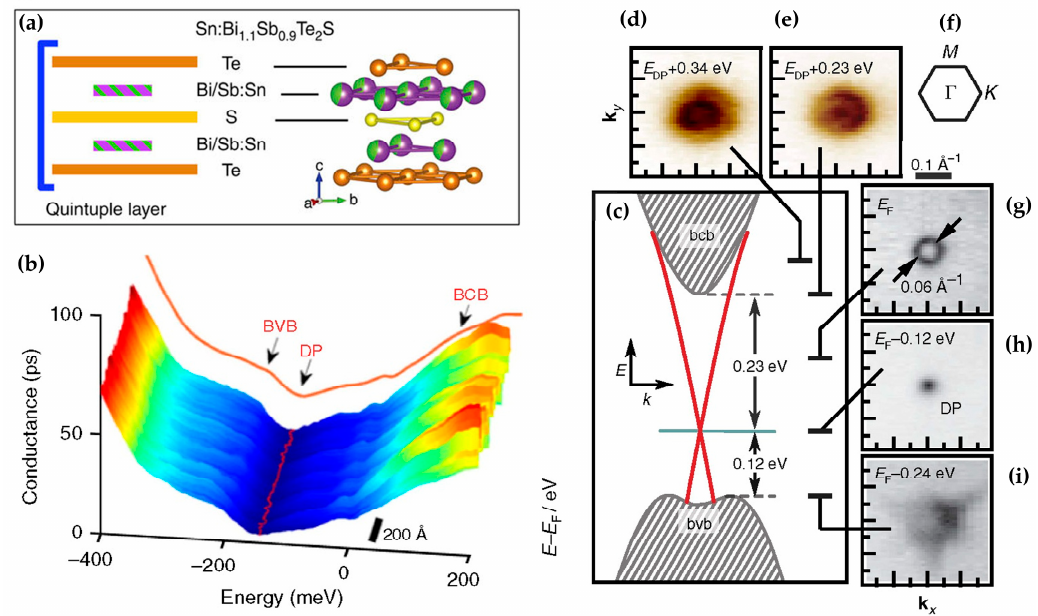
Figure 7. ( a ) The schematic of a QL for Sn:Bi 1.1 Sb 0.9 Te 2 S and a QL obtained by structure refinement of a powdered specimen; ( b ) The differential conductance (dI/dV) along a line shows only small fluctuations in the electronic surface structure (V bias = − 600 mV and I = 60 pA); ( c ) A schematic diagram for the electronic structure of Sn-BSTS in the vicinity of the Fermi energy derived from the angle-resolved photoemission spectroscopy (ARPES) data; ( d , e ) The DP E DP for the K-deposition-generated electron-doped sample; ( f ) A schematic diagram for Brillouin zone with high symmetry points; ( g – i ) The constant-energy ARPES maps [106].